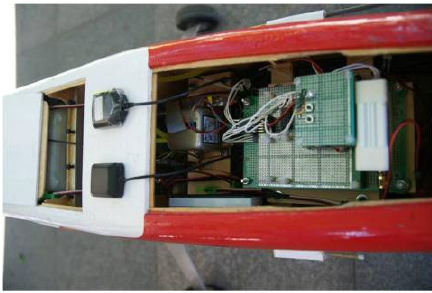
Figure 5 Setup DG module in UAV